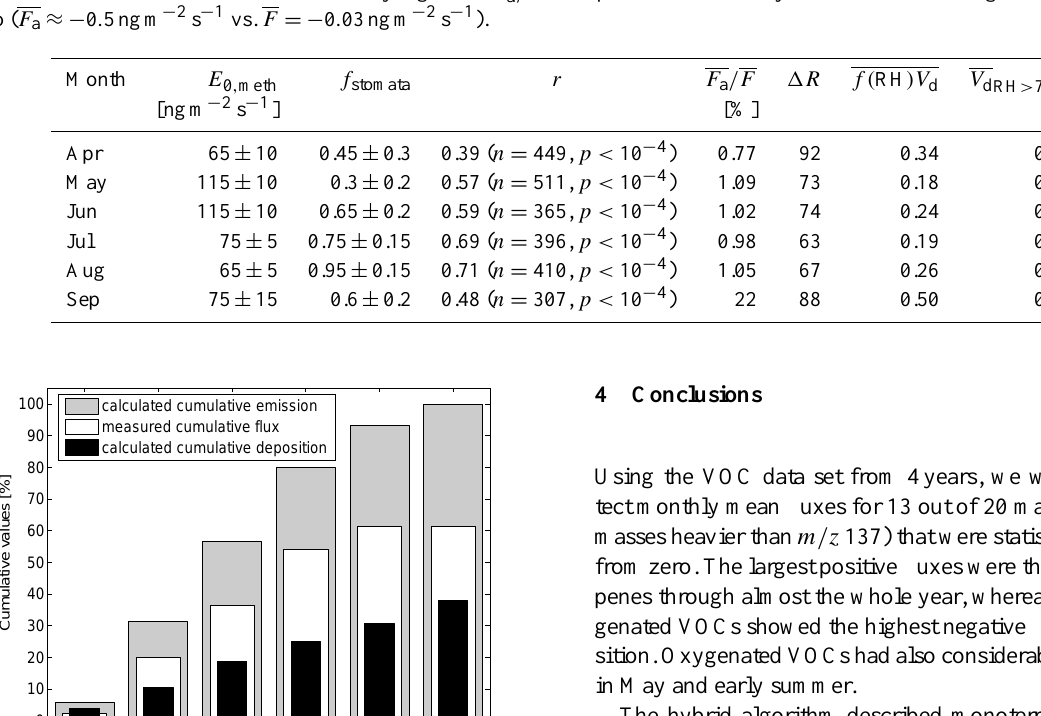
Table 5. The table presents methanol emission potential, E 0 , meth , including 95% confidence intervals. The table shows also correlations coefficients ( r ), relative errors between the measurements and the calculated values ( (cid:49)R ), and a ratio, F a /F , where F a is an average value of the calculated fluxes and F an average value of the measured fluxes. f ( RH )V d and V dRH > 75% are calculated (Eq. 13) mean deposition velocities (unitcms − 1 ). If the p value of a correlation was larger than 0 . 0027, the result was disregarded as statistically insignificant, and those values are not shown in the table. The really high ratio F a /F of September is caused by the fact that the average flux was really close